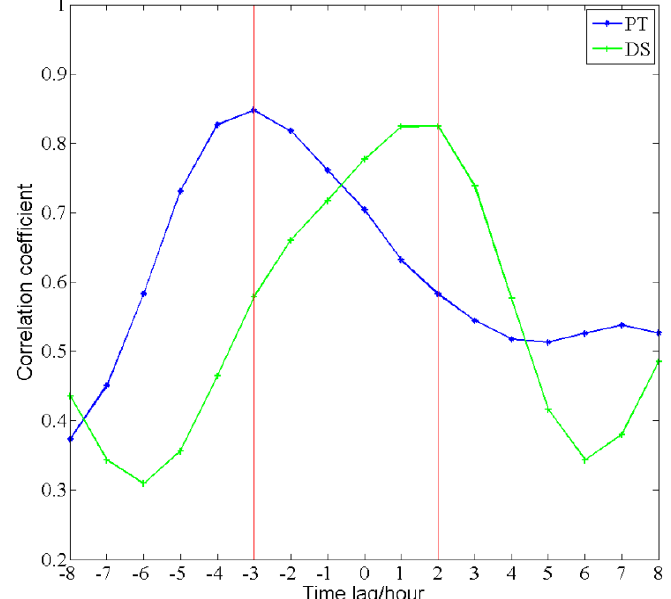
Figure 11. The lagged correlation coefficients of the model non-tidal sea surface height anomalies between PT and XM (blue) and between DS and XM (green). Negative values in the time lag mean the former station leading the latter for each pair. The model run is forced by both the tide and the NCEP wind modified by 1.3-times.